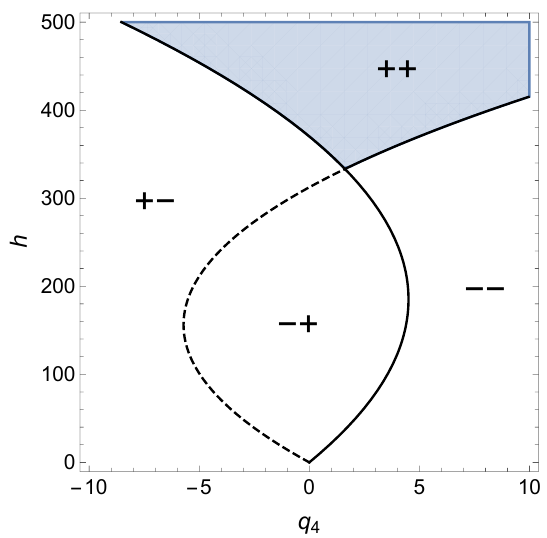
Figure 2 . Exclusion plot for W 4 charge q 4 and conformal weight h , with c = 10 4 ; q 3 = 0. The shaded region is allowed, i.e. has all eigenvalues positive. One eigenvalue of the level-one Kac matrix is non-negative everywhere in the plotted region, and the pluses/minuses show the signs of the other two eigenvalues. The dashed curve shows the null states referred to in footnote